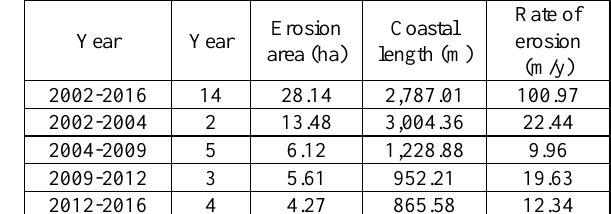
Table 5. Coastal changes between 2002 and 2016